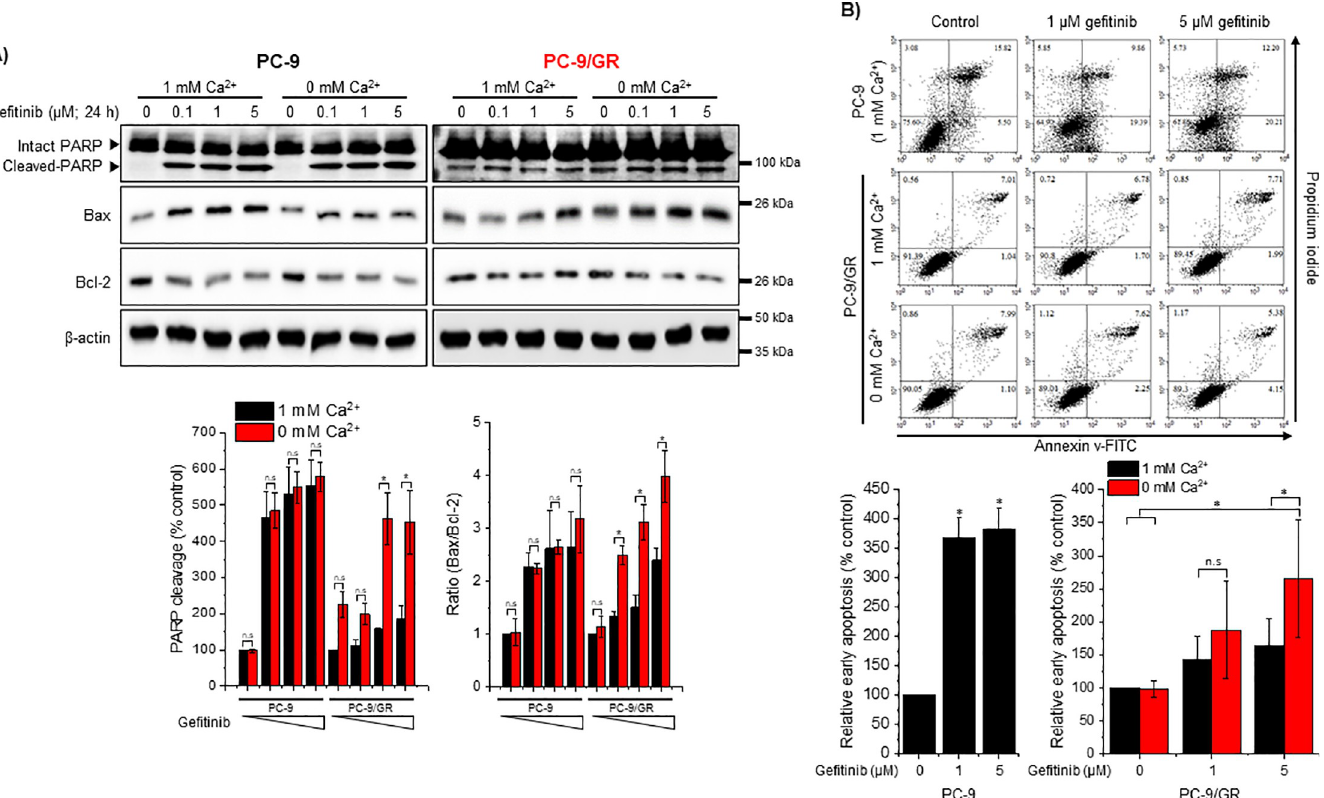
Fig 4. Effects of low [Ca 2+ ]e on gefitinib-mediated activation of apoptotic markers. (A) Whole-cell lysates were subjected to western blotting with antibodies to PARP, Bax, Bcl-2, and β -actin. Quantification of PARP cleavage and Bax/Bcl-2 ratio is presented as relative to control (% control; vehicle-treated PC-9 cells in 1 mM [Ca 2+ ]e, n � 3). (B) 10,000 cells stained with Annexin V-FITC and PI were evaluated using flow cytometry. Data are percentages compared with control (non-gefitinib- treated) and presented as mean ± S.D. � P < 0.05 compared with control or between indicated groups.